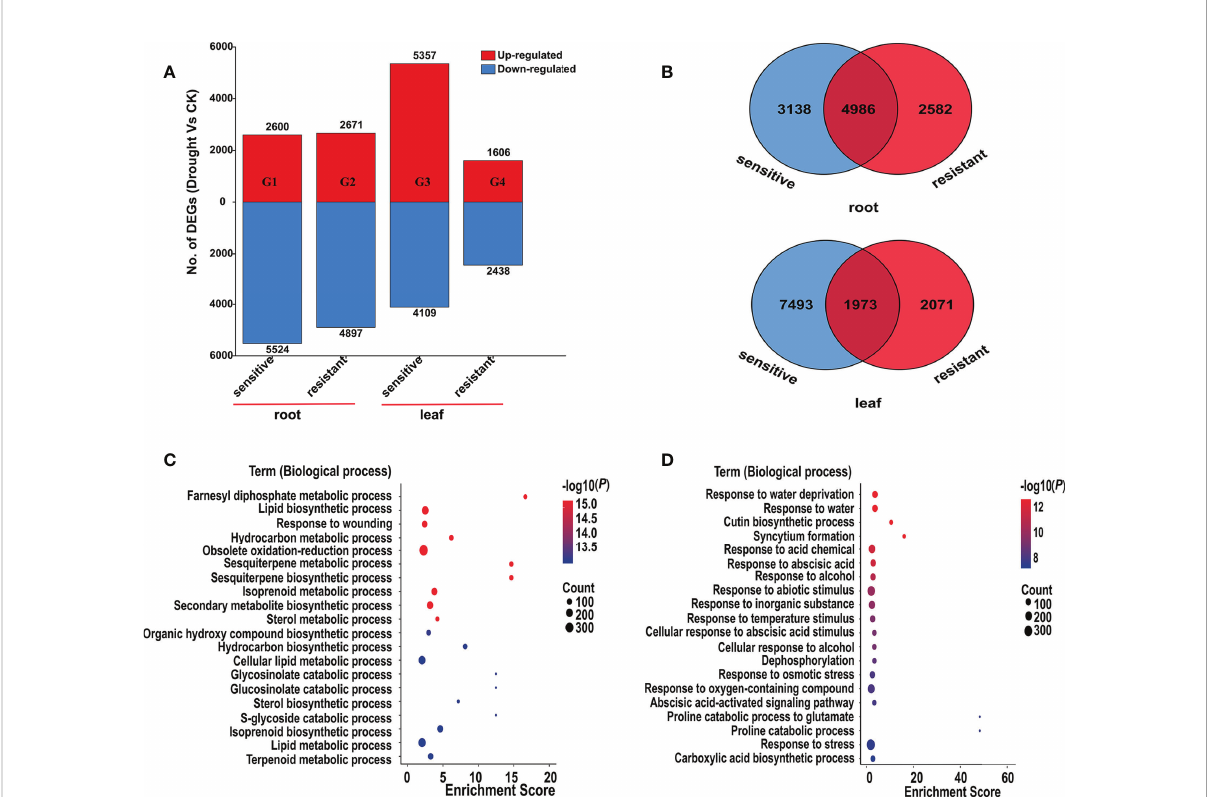
FIGURE 2 Differentially expressed genes (DEGs) in root and leaf. (A) , Number of upregulated genes (red) and downregulated genes (blue) in four comparative groups (G1 ~ G4). You can see the speci fi c information of these four comparative groups in the Table S3. (B) , Venn diagram of DEGs among root and leaf. (C, D) , Bubble chart of GO enrichment analysis of the DEGs in root (C) and leaf (D) . The ordinate represents different GO terms (biological progress) and the abscissa represents enrichment Score. Circle size represents the gene number while circle color represents the value of − log10 ( P ). The P value was corrected by Benjamini & Hochberg (BH)